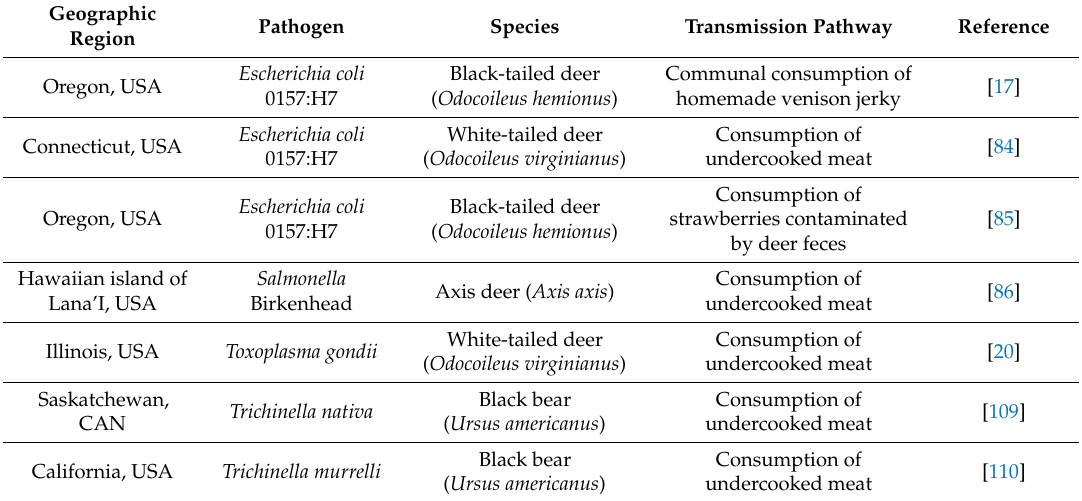
Table 1. Overview of the primary foodborne diseases originating from free-ranging mammal game animals in North